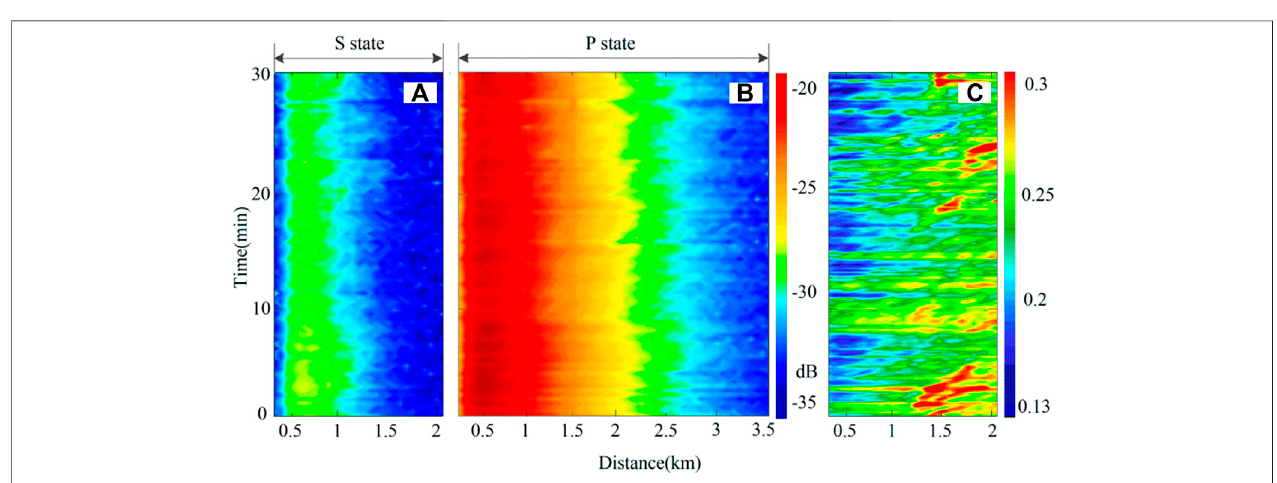
FIGURE4|(A) Thecarrier-to-noiseratio(CNR)distributionofSstates. (B) TheCNRdistributionofPstates. (C) Thedistributionofdepolarizationratiomeasuredby the polarization